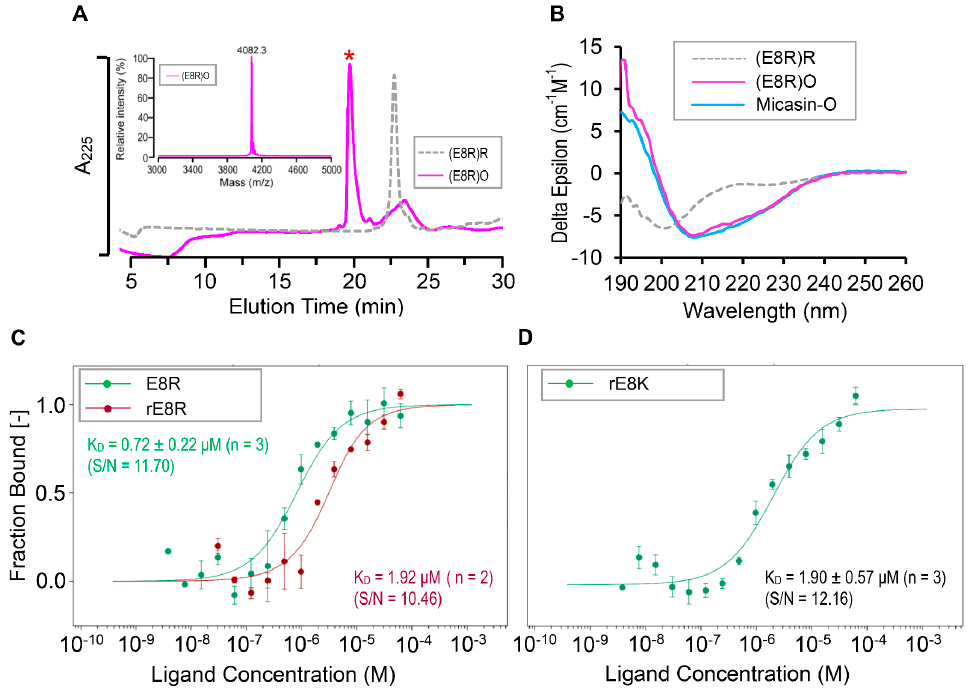
Figure 6. Interactions between micasin mutants and RBD. ( A ) Oxidative folding from the chemically synthesized reduced E8R. The oxidized product is marked by a red asterisk. Inset: the MALDI − TOF image. ( B ) Comparison of CD spectra of E8R between its oxidized (O) and reduced (R) forms. Micasin is used as a control. ( C ) Comparison of E8R binding to RBD between synthetic and recombinant versions. ( D ) Binding of E8K in its recombinant version. Error bars are SDs from two to three independent measurements. In panels ( C , D ), the curves were fitted with the K D model. The experiments were performed at 25 °C at high MST and 20% LED power. S/N, signal − to − noise ratio. Notice: preparation of chemically synthesized oxidized micasin and recombinant E8R and E8K samples have been reported previously [24,37].